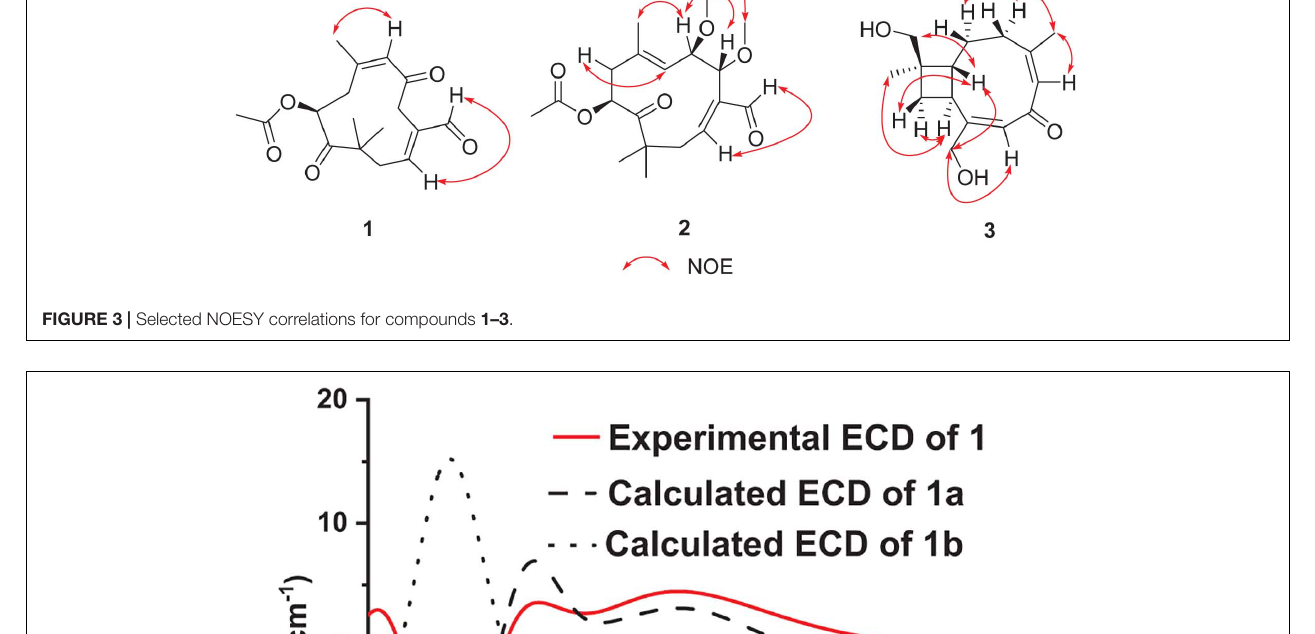
C-6/C-7 olefin at C-7. Key HMBC correlations ( Figure 2 and Supplementary Figure 5 ) from H 2 -4 to C-5 and C-6 linked C-4 to the ketone carbon C-6, completing an 11-membered